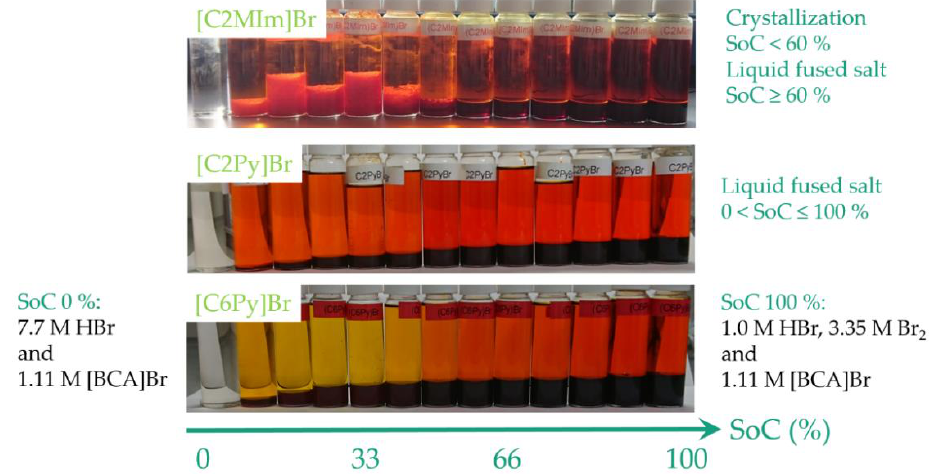
Figure 4. Photos of electrolyte samples with different BCAs [C2MIm]Br, [C2Py]Br and [C6Py]Br as a function of SoC for an SoC of 0, 10, 20, 30, 33, 40, 50, 60, 66, 70, 80, 90 and 100%. For electrolytes with [C2MIm]Br, between 0 < SoC < 60%, the second electrolyte phase is shown to precipitate and to form crystals. For [C2MIm]Br at SoC ≥ 60%, [C2Py]Br, as well as [C6Py]Br in the entire SoC range, the formation of a liquid fused salt phase occurs at room temperature. With increasing SoC, the volumes of the fused salt phase increase. In particular for the application of [C6Py]Br, the coloration of the aqueous phase from yellow to brown shows that the bromine concentrations increase with increasing SoC. In addition, the SoC range is specified by total concentrations for an SoC of 0% and 100%.